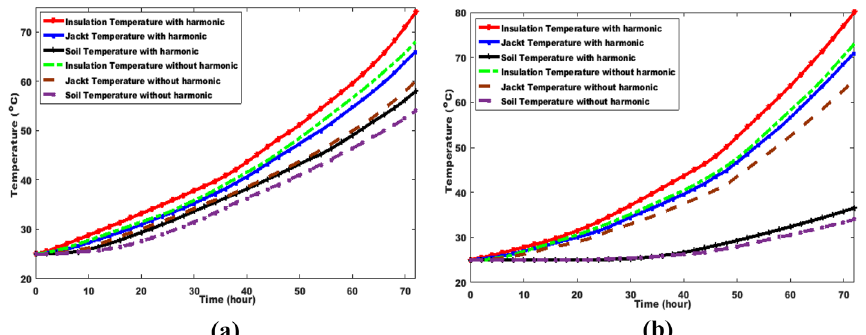
Fig. 12 Comparison of dynamic temperature of the cable layers and surrounding soil using thermal method a With sinusoidal and non-sinusoidal current at direct buried, b with sinusoidal and non-sinusoidal current source at installed inside PVC duct in the